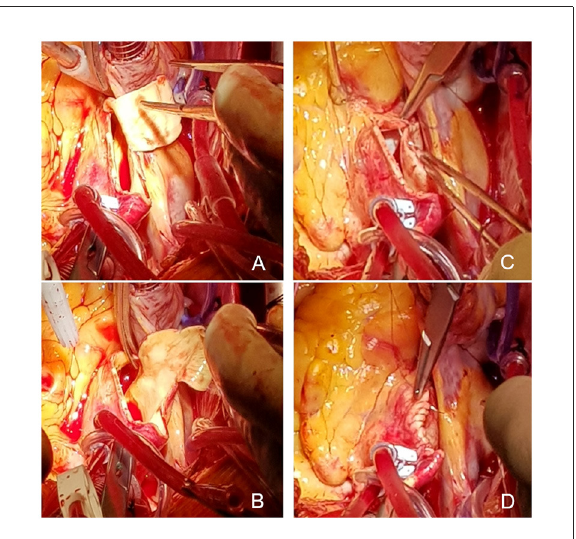
FIGURE1 Reduction Ascending Aortoplasty by tissue resection in a wedge-shaped fashion (A,B) and suture line completion in a double-layered fashion (C,D)